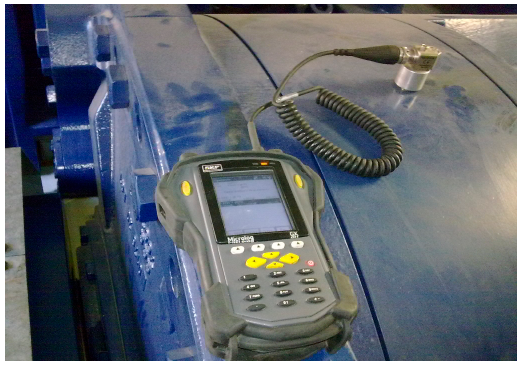
Figure 7. Portable data acquisition system for wind turbine drivetrain.